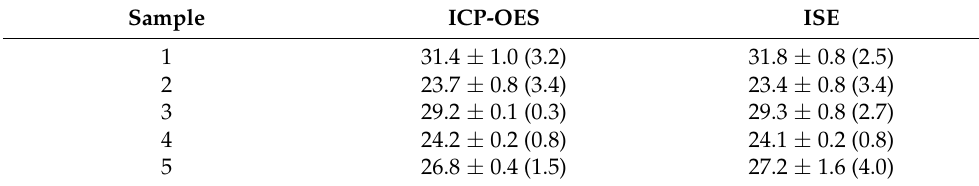
Table 1. Ag + concentration in ppm by ICP-OES and ISE analysis, RSD values are in